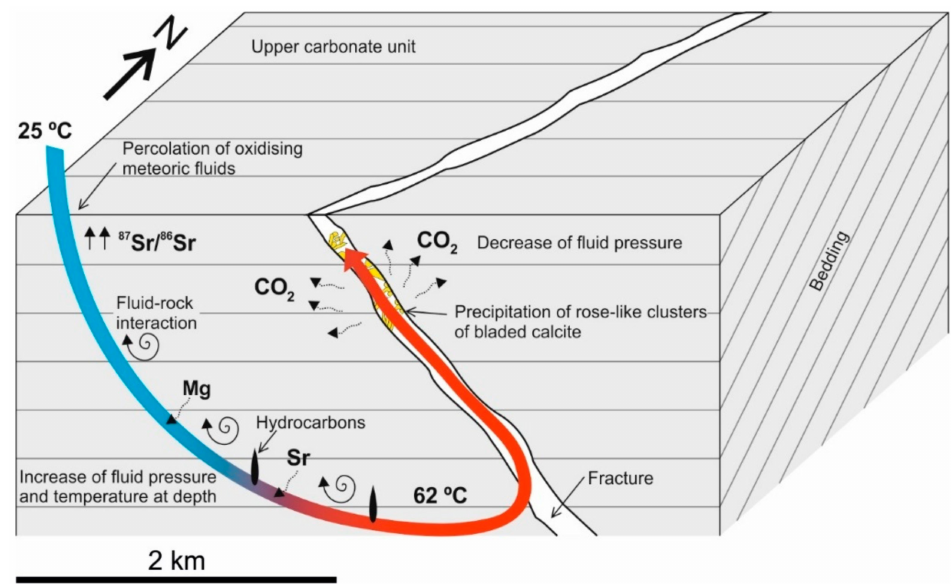
Figure 14. Conceptual precipitation model for the rose-like clusters of bladed calcite crystals in the northern side of the Cad í thrust